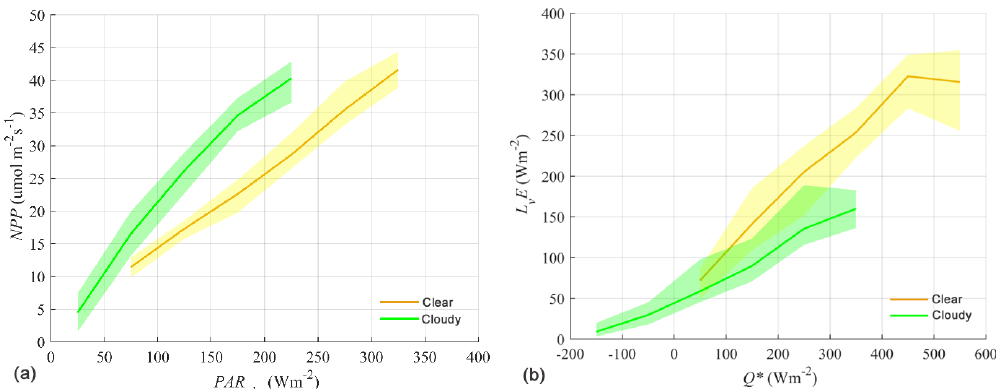
Figure 10. (a) Net primary production (NPP) versus photosynthetic active radiation (PAR). (b) Latent heat ( L v E ) versus net radiation ( Q ∗ ). In both figures, the observation period encompasses clear and cloudy skies during a 2-week period starting on 7 May 2018 at 03:30UTC (sunrise) and ending on the 20 May 2018 at 19:40UTC (sunset). The solid line represents the median of the data. The lower and upper boundaries of the shaded area are the 25th and 75th percentiles of the data,